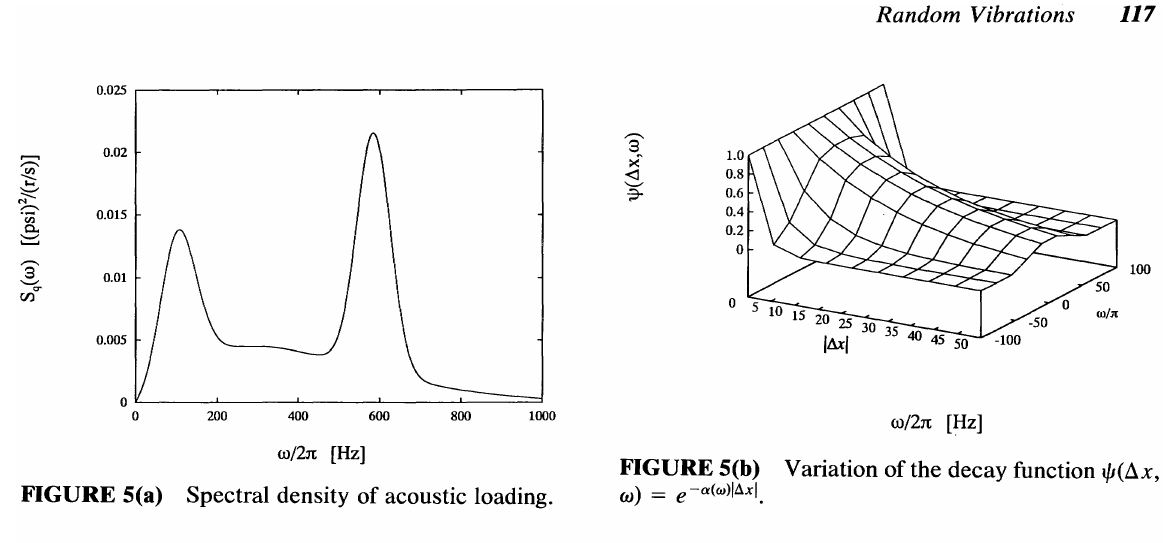
FIGURE 5(a) Spectral density of acoustic loading.